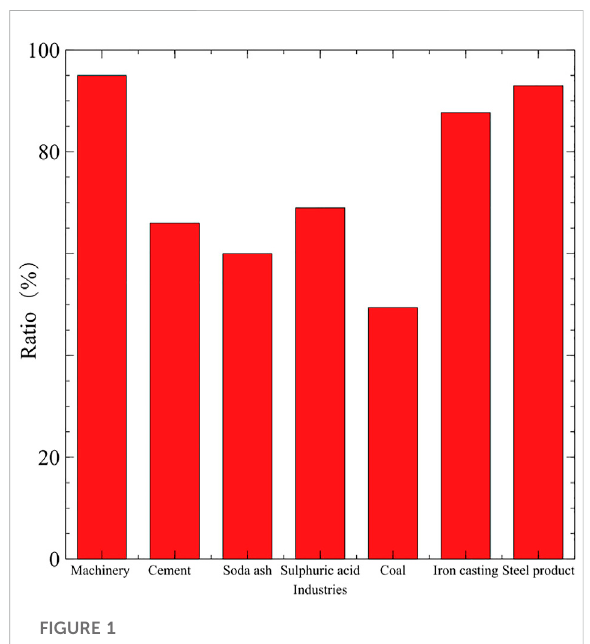
FIGURE 1 Ratio of resources in Northeast China to national output in